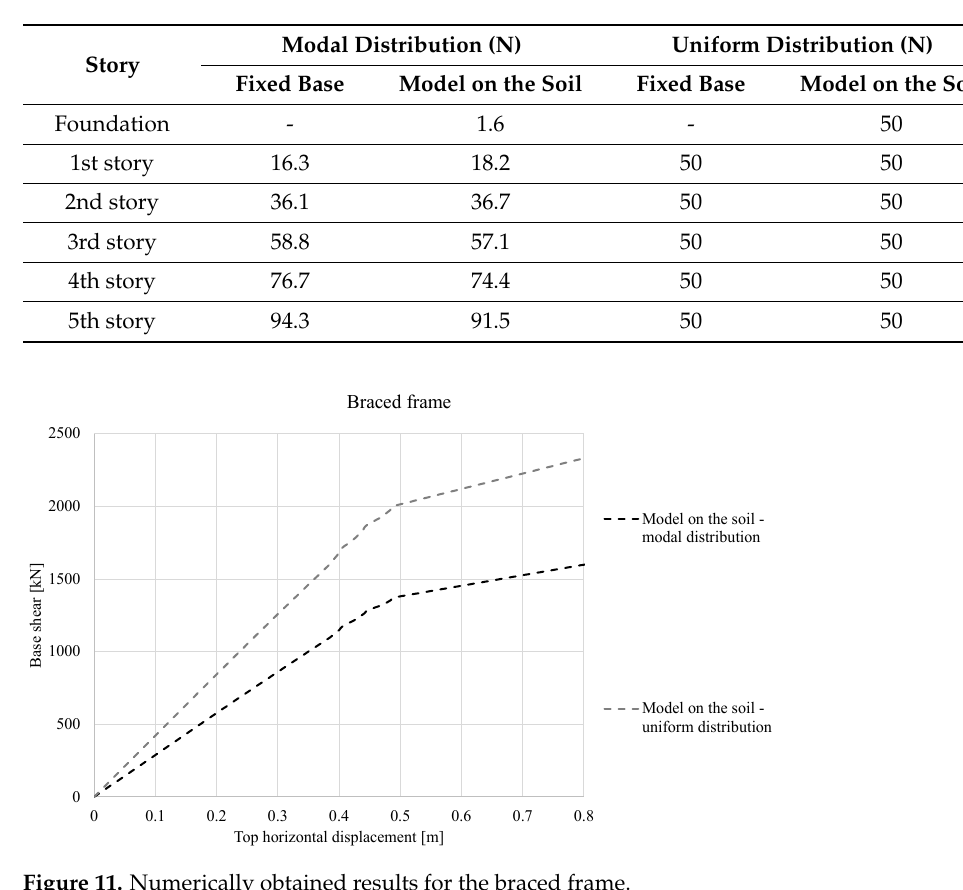
Table 5. Lateral load distributions for braced frame.